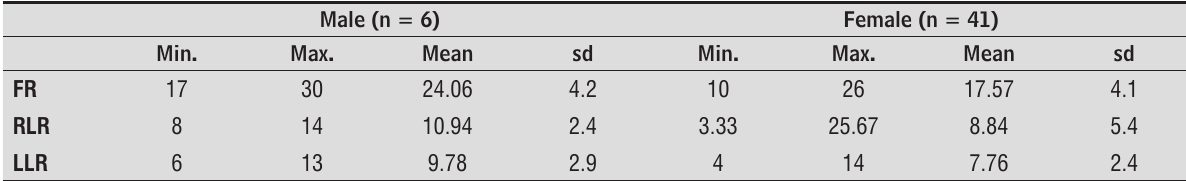
Table 2 - Values of Functional Reach and Lateral Reach